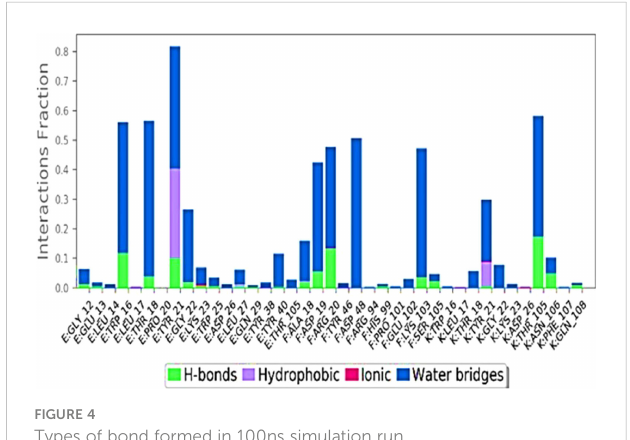
FIGURE 4 Types of bond formed in 100ns simulation